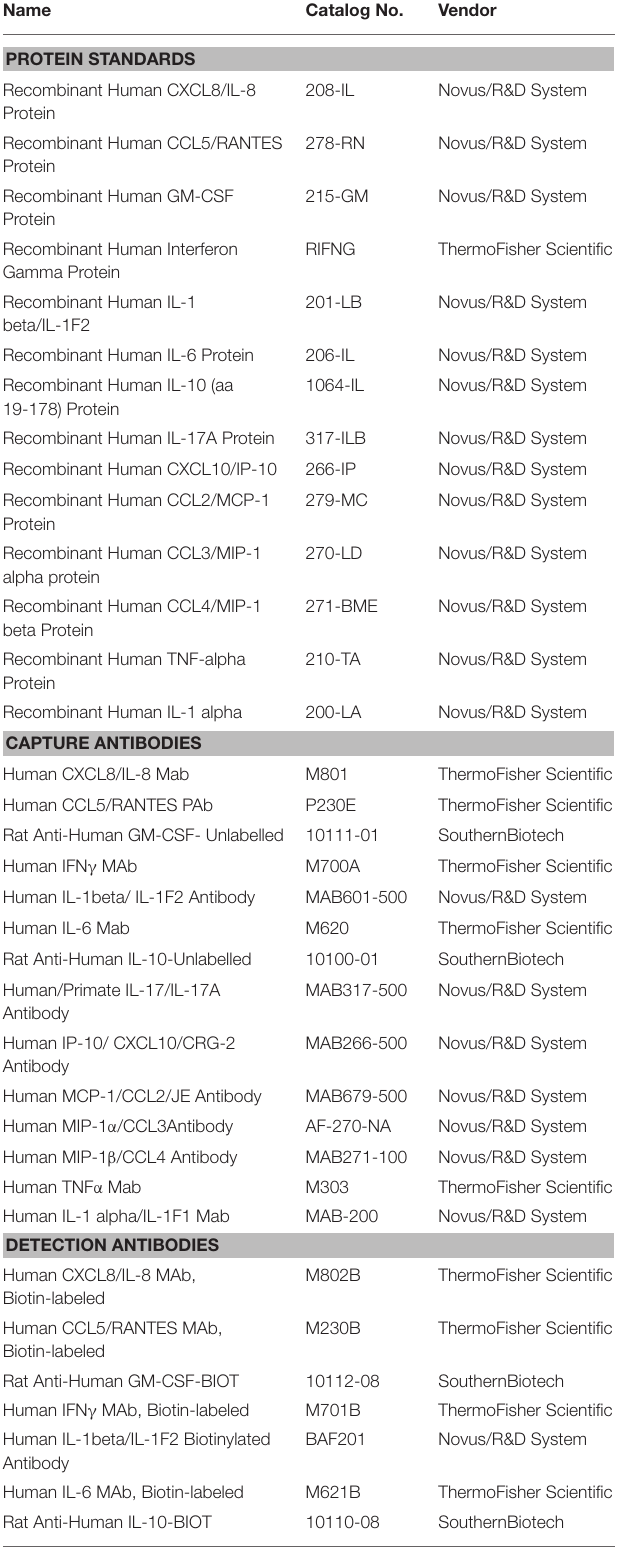
TABLE 1 | Protein standards and